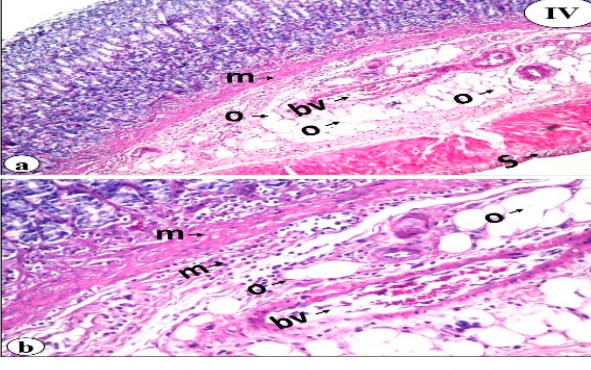
Figure 3. III-a. Showing mild congestion in Figure 3. IV-a. Showing oedema (o) with focal in- blood vessels with few focal inflammatory flammatory cells infiltration (m) and congestion of cells infiltration (m) in submucosa (H&E x16), blood vessels (bv) in submucosa, IV-b: showing the III-b: indicating the magnification (×40) of Fig- magnification (×40) of Figure IVa to identify oedema; ure III-a to identify the few focal inflammatory focal inflammatory cells infiltration with congestion cells infiltration in submucosa; also mild con- of blood vessels in submucosa and oedema in mus- gestion of blood vessels (bv) in submucosa cularis (O) in KF-treated group (H&E × 16). were observed in SP-treated group (H&E × 16). Figure 3. Cont